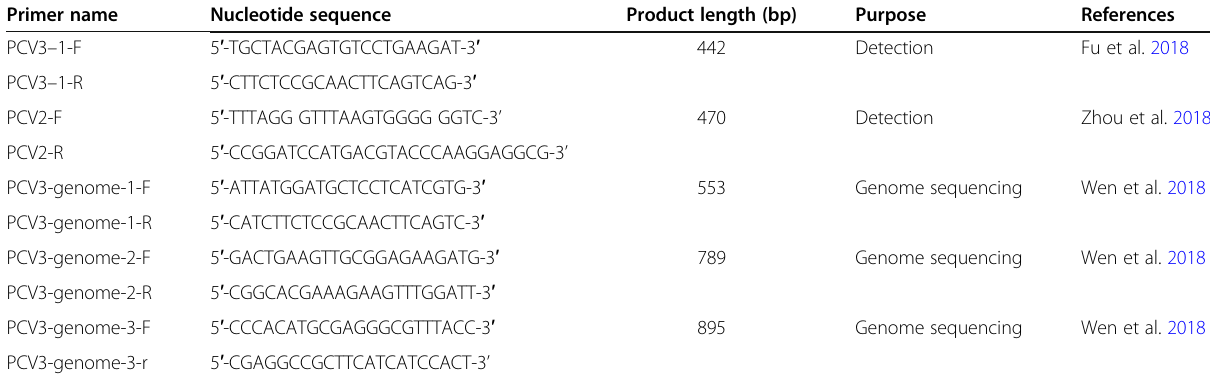
Table 2 List of primers used in this